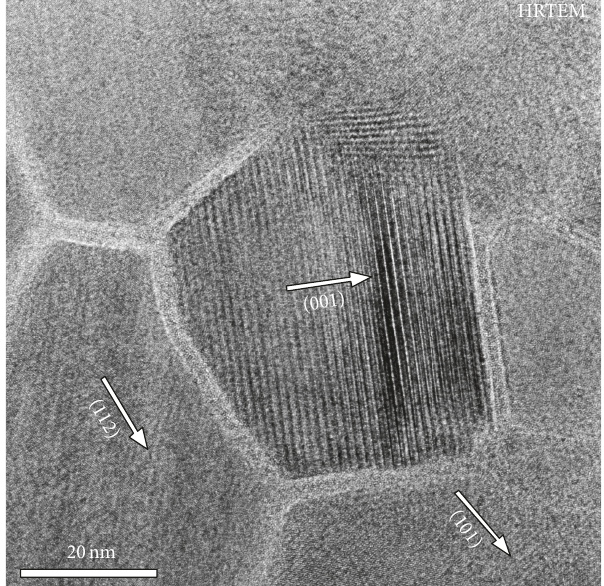
Figure 5: HRTEM image of randomly orientated grains separated by amorphous GBs. The (001), (112), and (101) lattice fringes of three grains are visible.